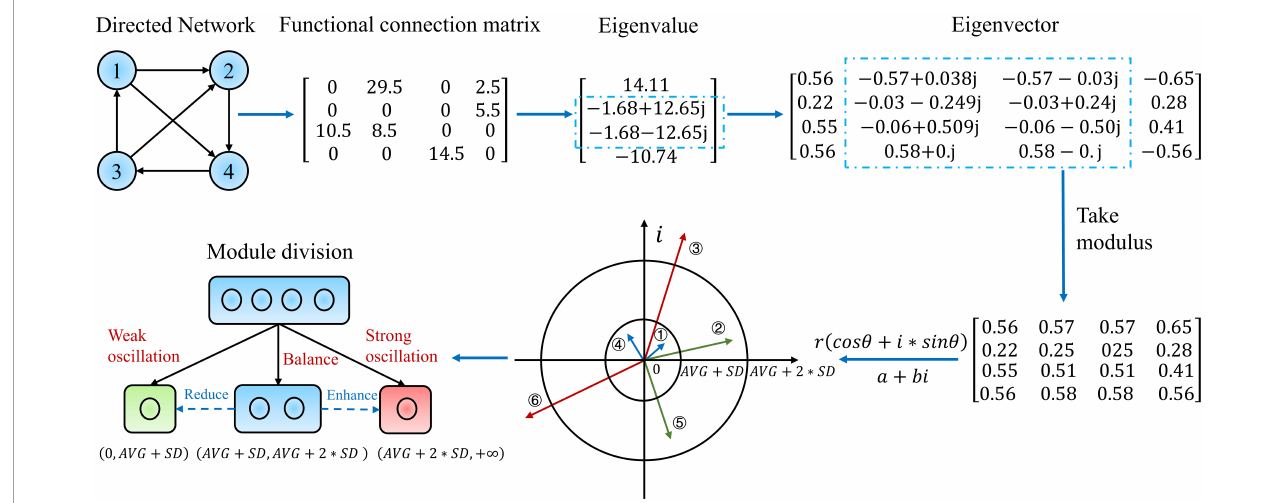
FIGURE1 Example illustration and detailed description of the eigenmode analysis method. This diagram demonstrates a weighted directed network with four nodes. This network is then assigned a functional connectivity matrix corresponding to the hundred-dimensional matrix acquired from the real epilepsy causal effects network. The eigenvalues and eigenvectors of this matrix are then determined. The eigenvectors are then retrieved in modal length, and their interpretation in the complex plane is provided. The module is subdivided into three submodules based on the modal lengths of the eigenvectors, and the subfigure at the bottom left depicts the precise meaning and classification links of the hierarchical modularity method to oscillatory dynamic